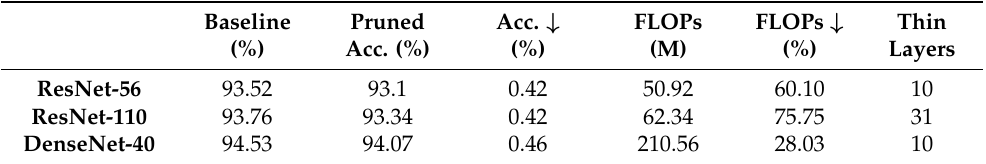
Table 1. Results of dynamic pruning on CIFAR10. “Acc.” indicates accuracy. “Acc. ↓ ” and “FLOPs ↓ ” denote reductions compared to the base models. The other tables and figures follow the same